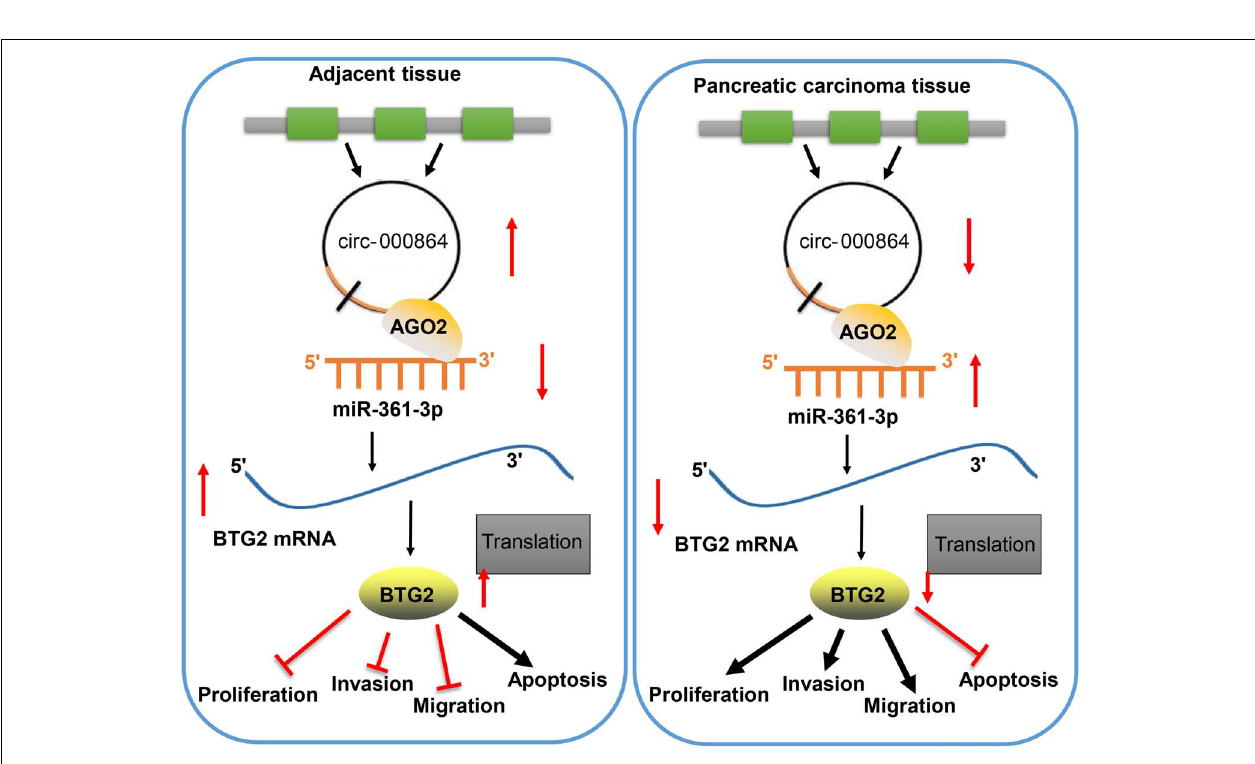
FIGURE 8 | The mechanism of circRNA_000864 in pancreatic cancer by binding to miR-361-3p and BTG2. Upregulating circRNA_000864 expression could impair miR-361-3p-dependent BTG2 downregulation and inhibits the proliferation, invasion, migration, and promotes apoptosis of pancreatic cancer cells.